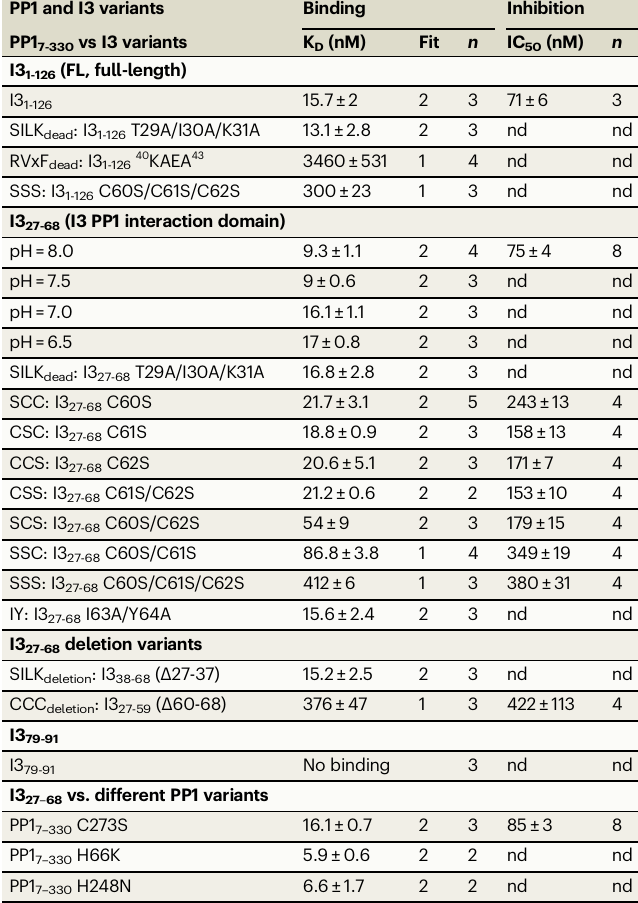
Bold usedtohighlight different I3 constructsandPP1